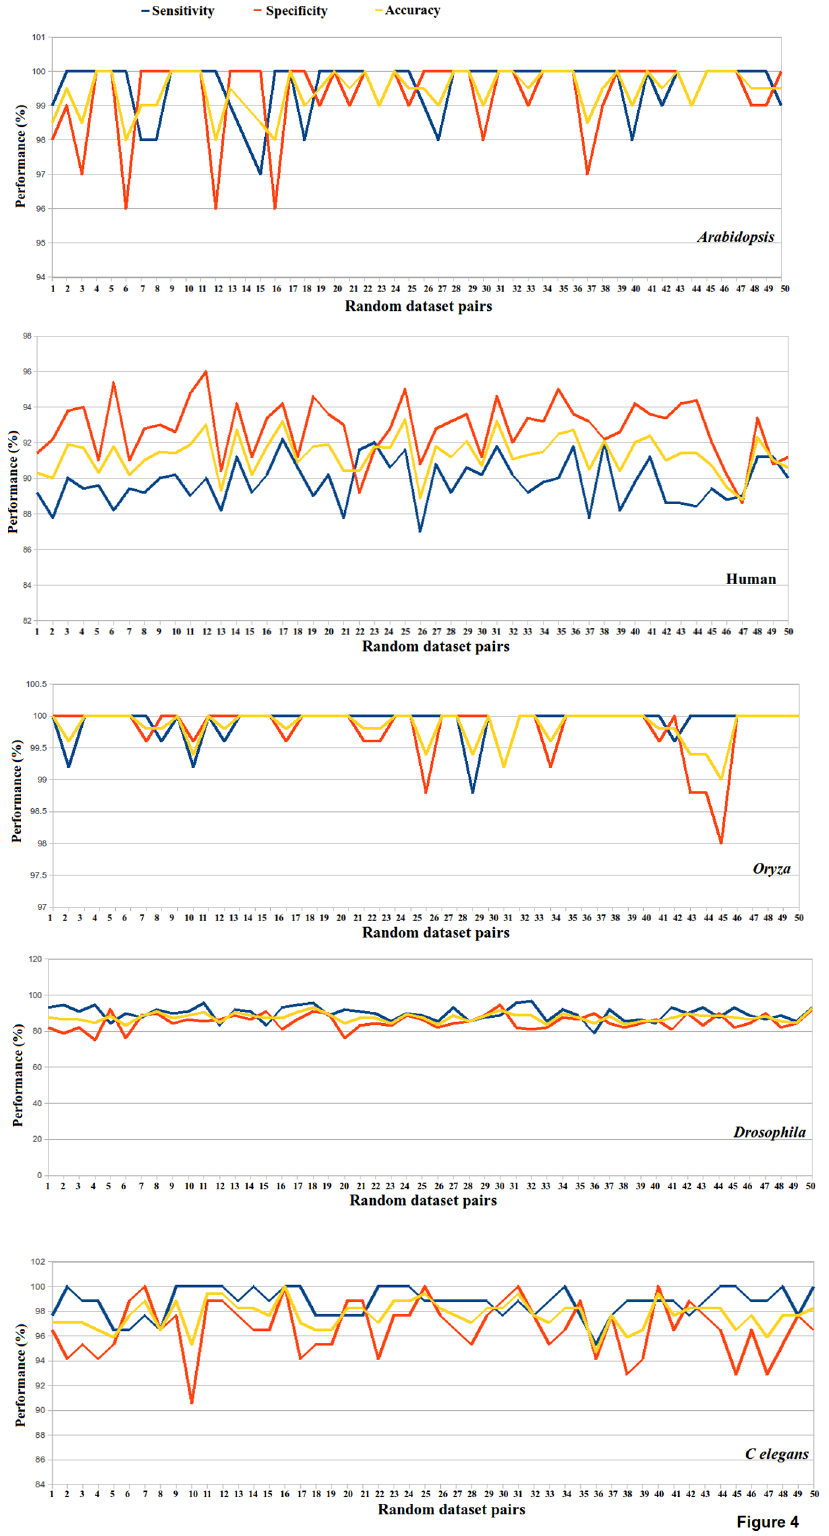
Figure 4. Accuracy on random datasets. Different randomly selected instances were used to build the training and testing sets every time. For all such variable tests and for all species considered, the developed models performed consistently with high accuracy.